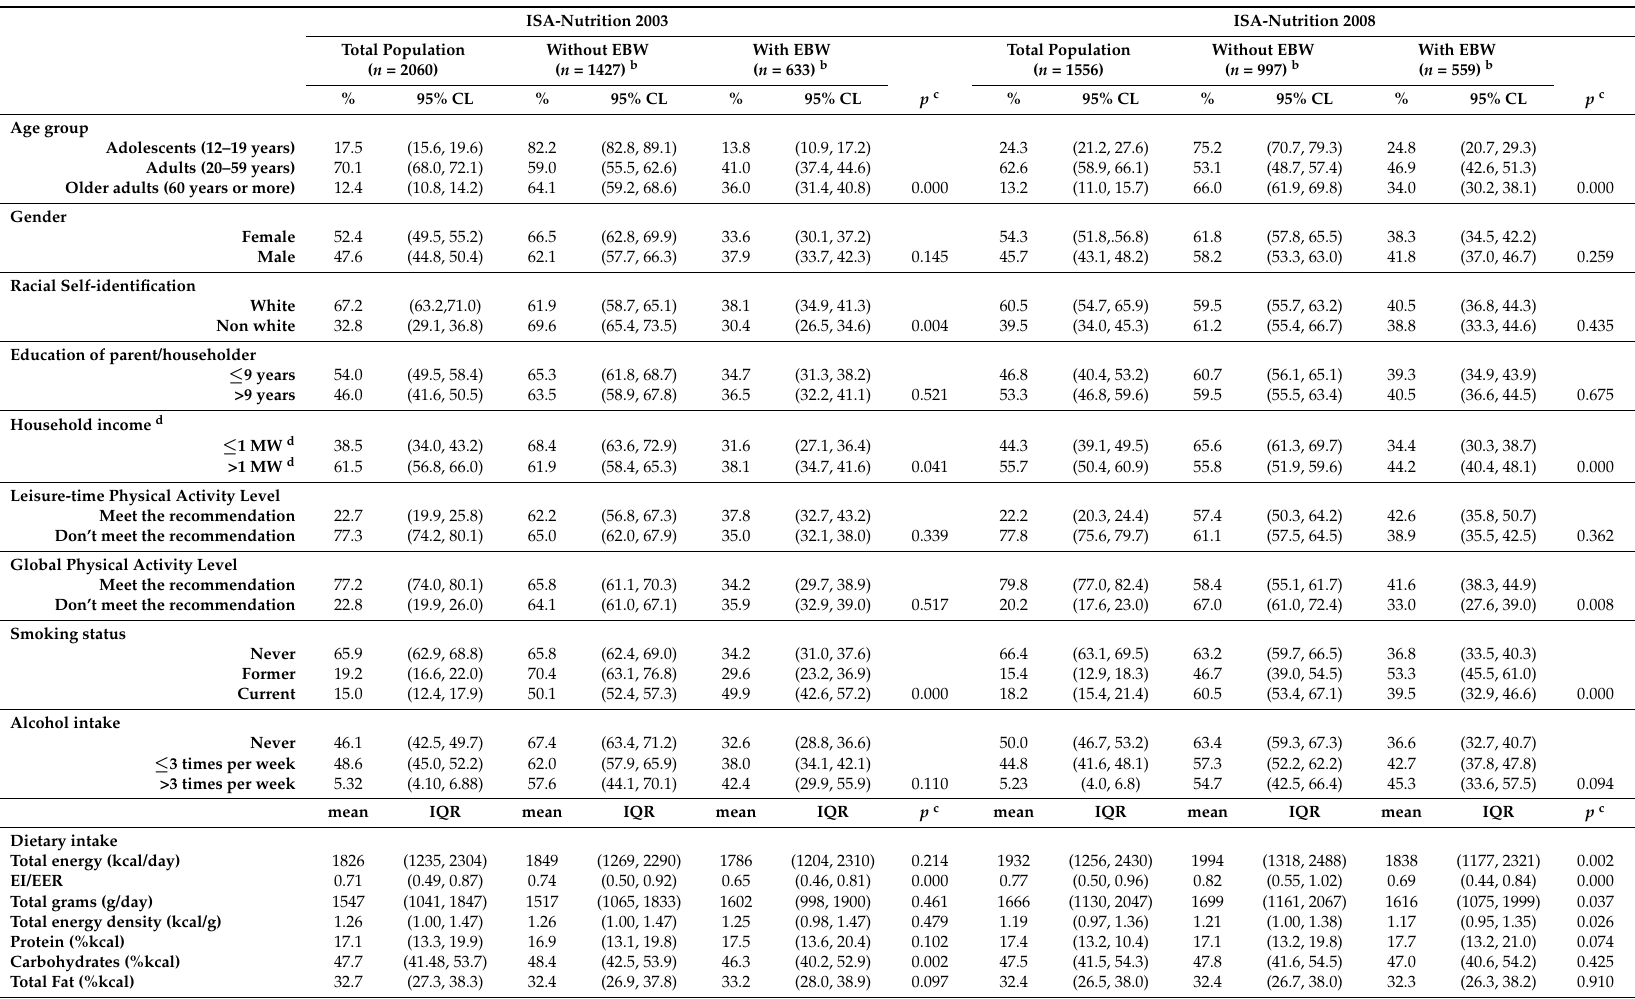
Table 1. Characteristics of the population in the ISA-Nutrition in 2003, 2008 and 2015, according to body weight status a